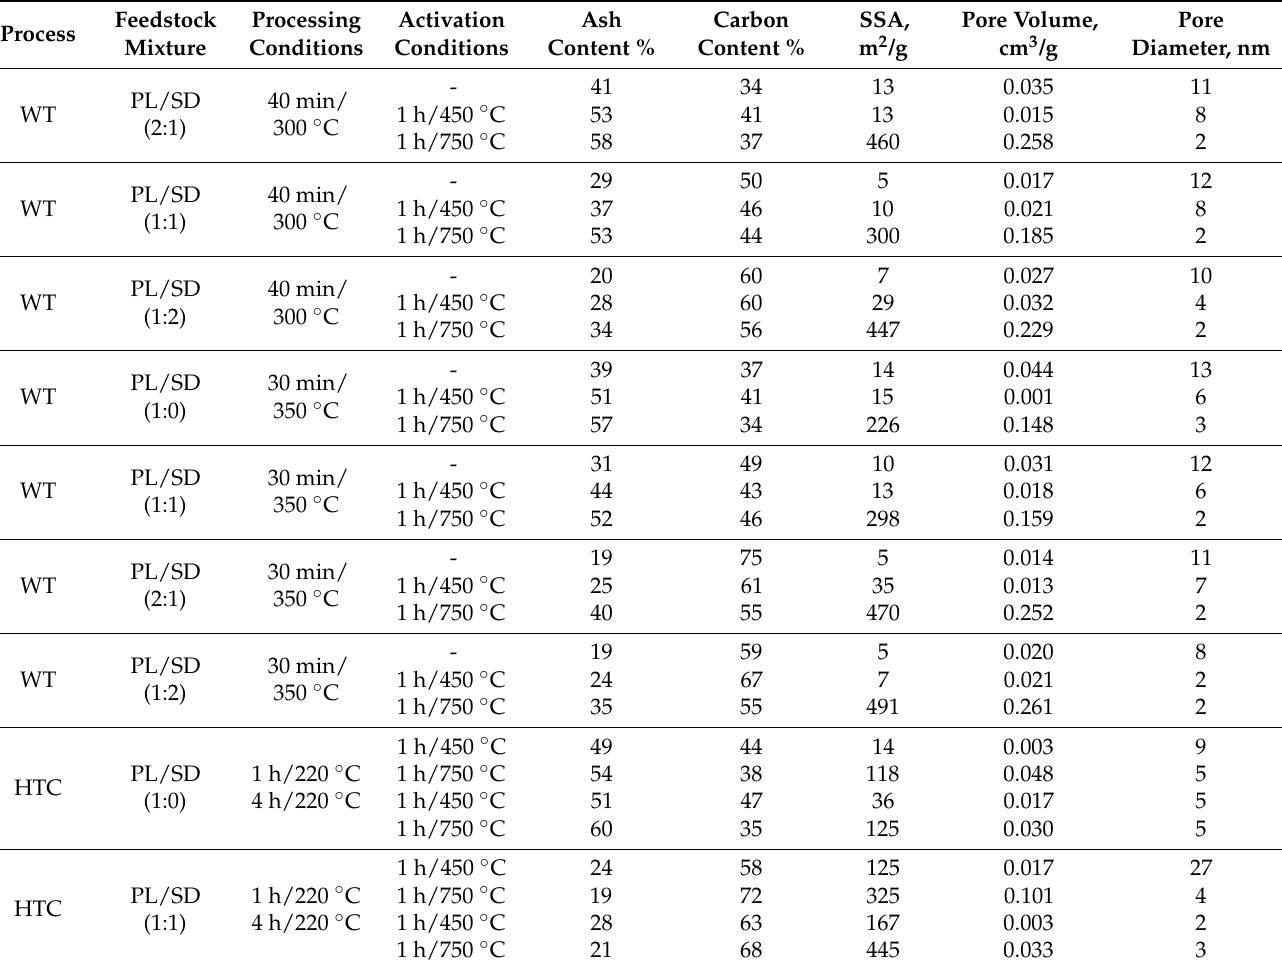
Table 1. Characteristics of activated hydrochars obtained after WT or HTC followed by physical steam activation. Feedstock Process